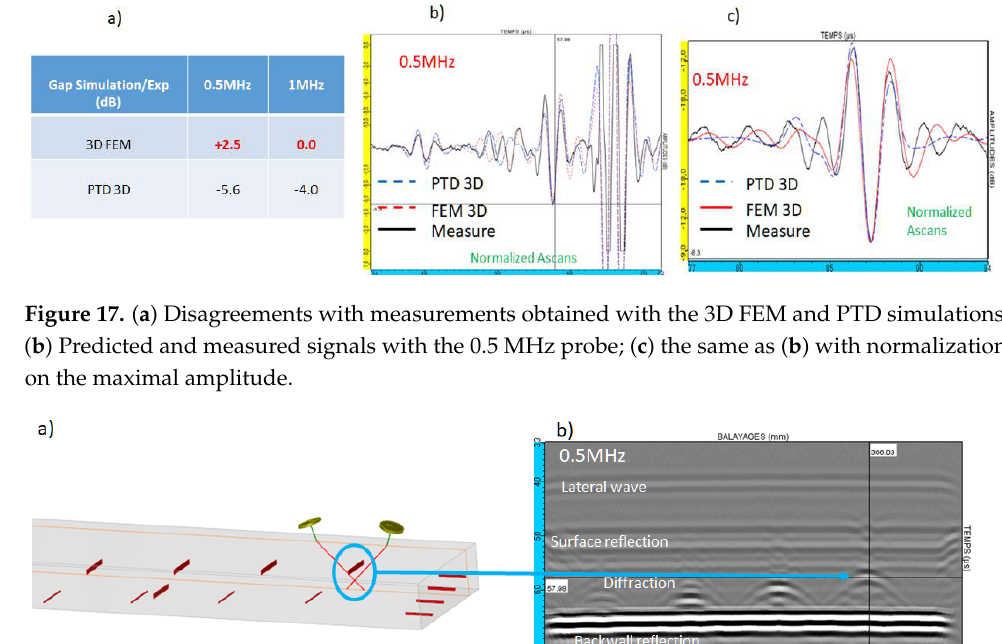
Figure 18. ( a ) S45°TOFD immersion inspection of several embedded planar electro eroded slots; ( b ) experimental BScan obtained when scanning the notches and the flat bottom holes at 0.5 MHz.